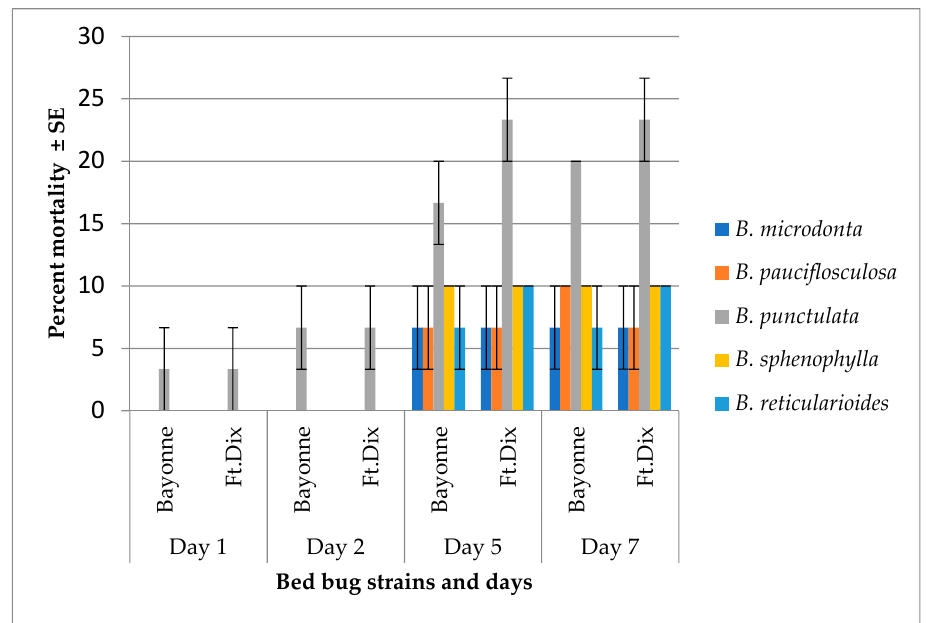
Figure 3. Mean percent mortality (±SE) caused by the essential oils (EOs) of five species of Baccharis applied topically on bed bug Cimex lectularius. Essential oil dose: 50 μ g/bug, deltamethrin (standard) produced 100% (Ft. Dx.) and 56.67% (Bayonne) mortality at 2.4 ng/bug 24 h after treatment. Mean and standard error were calculated in JMP